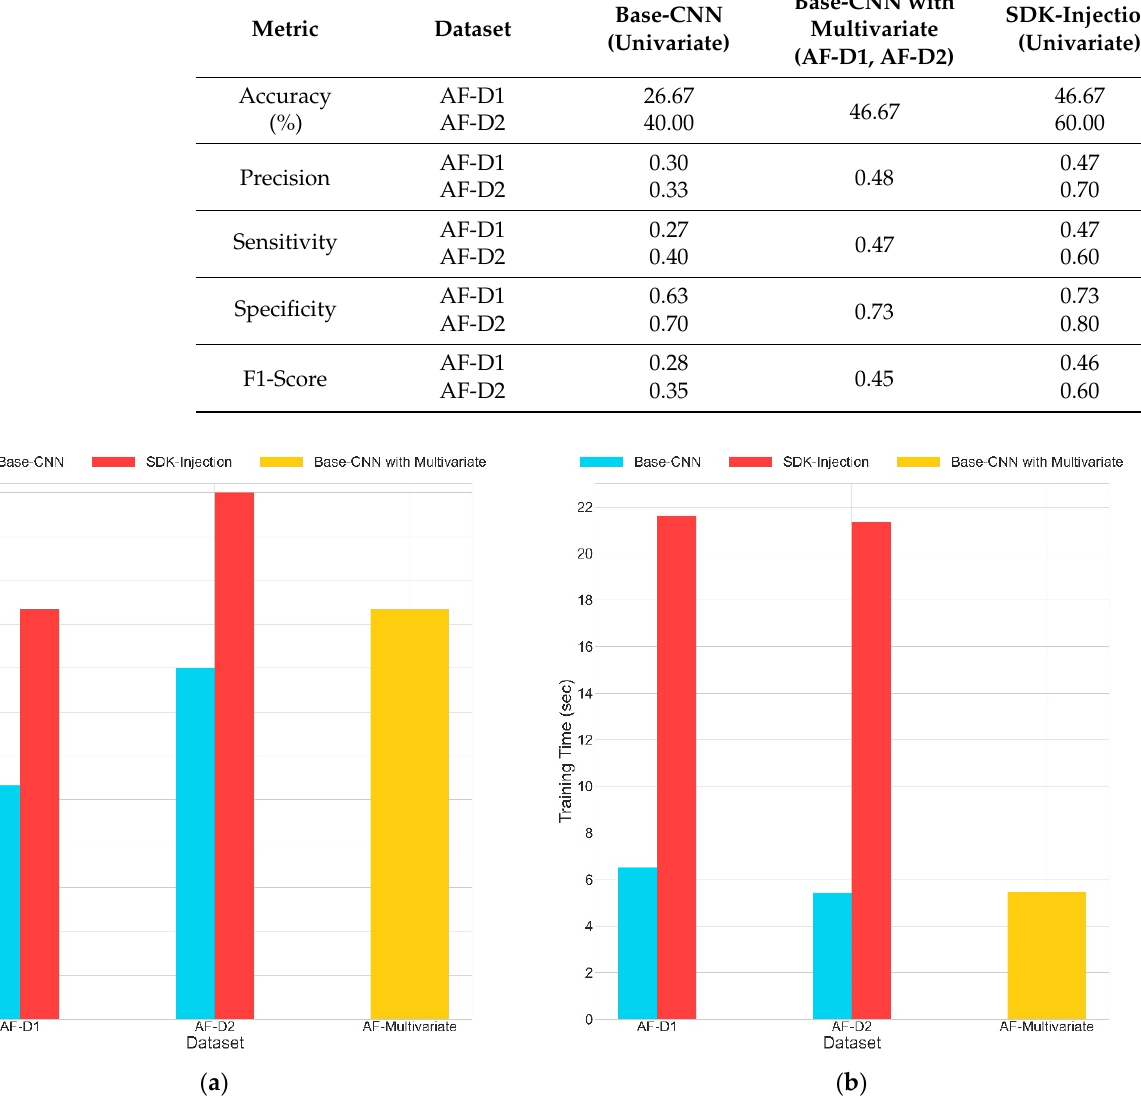
Figure 8. Performance when applying SDK-Injection on univariate data compared with Base-CNN with multivariate data: ( a ) accuracy when applying Base-CNN (sky blue) and SDK-Injection (red) to univariate inputs AF-D1 and AF-D2, respectively, compared with the accuracy of the Base-CNN with dual-variate input composed with AF-D1 and AF-D2 (yellow); ( b ) additionally, training time for the same situation.